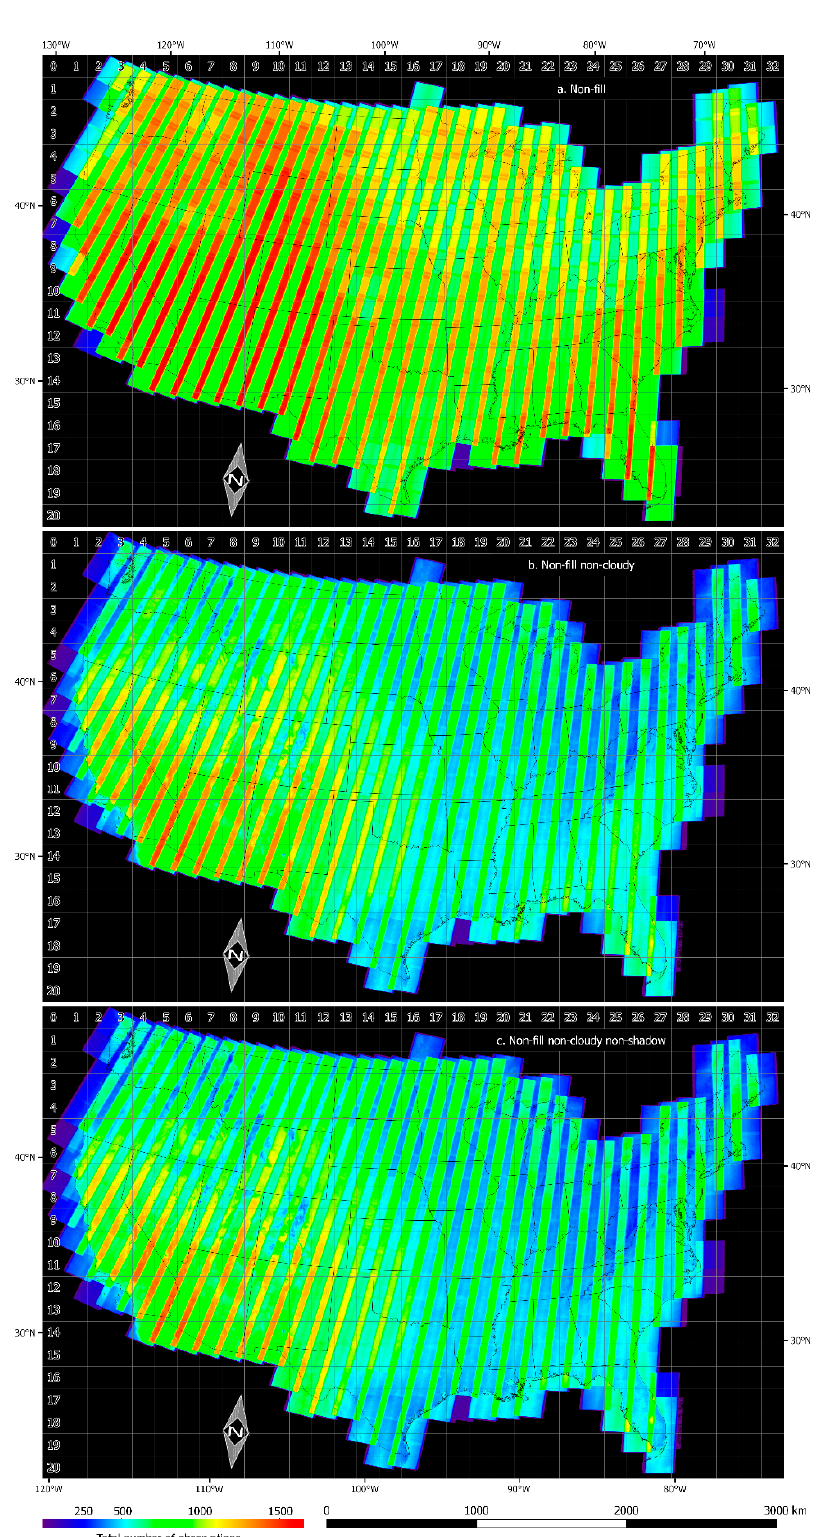
Figure 4. Total number (see color scale) of ( a ) non-fill, ( b ) non-fill non-cloudy and ( c ) non-fill non-cloudy non-shadow Landsat 4 TM, 5 TM and 7 ETM+ observations at each CONUS ARD 30 m pixel location over the 36 year study period.